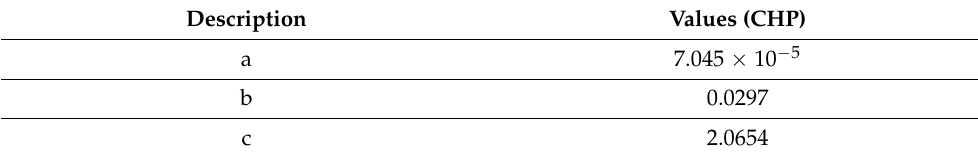
Table 3. The CHP Input-Output Curve (where (a, b, c) are the fuel cost